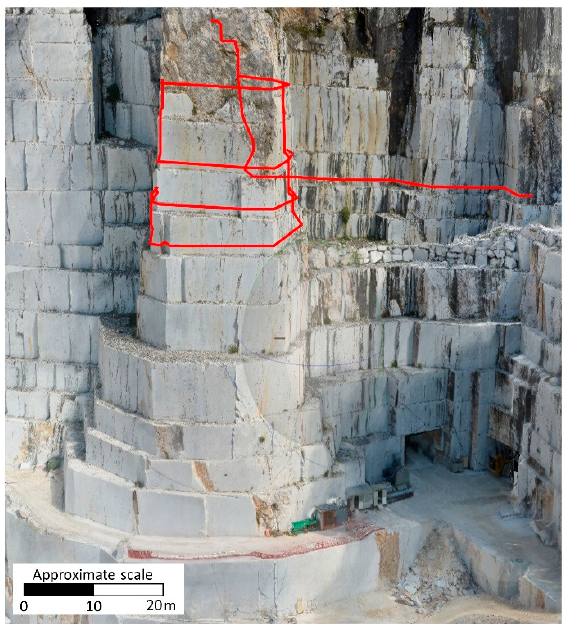
Figure 10. Textured 3D polygonal mesh of the marble buttress with the DOFS spatial distribution highlighted in red.